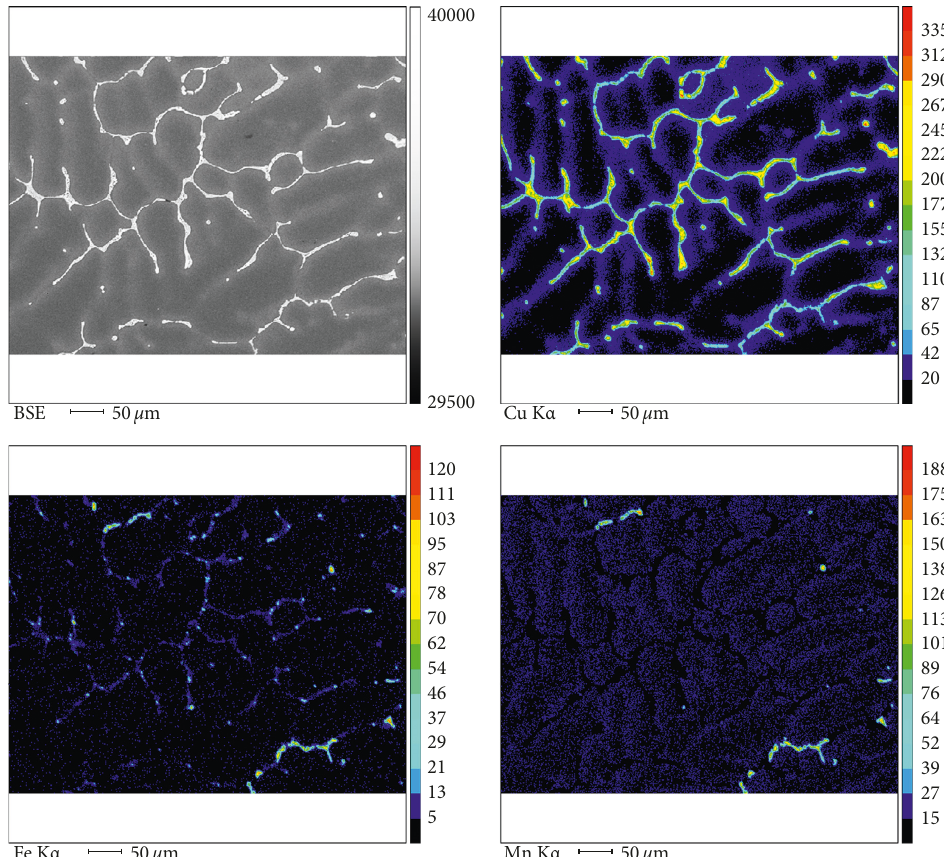
Figure 7: EPMA microstructure in the A 2 alloy as-cast, showing the distribution of solute elements of Cu, Fe, and Mn (for interpretation of the references to color in this figure legend, the reader is referred to the web version of this article).